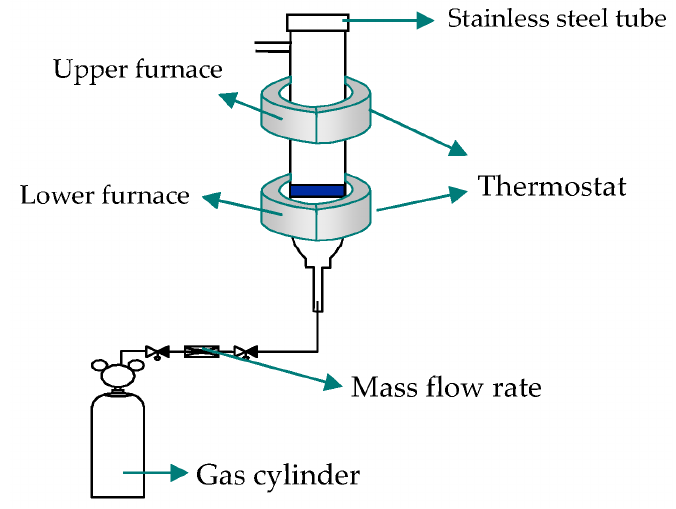
Figure 2. Schematic diagram of the chemical vapor deposition-fluidized bed reactor (CVD-FBR) used in this study.